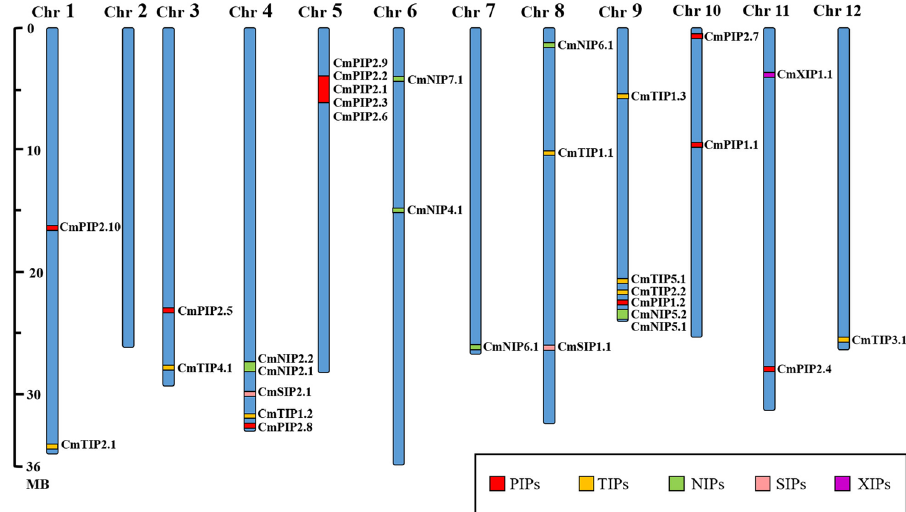
Figure 2. Chromosomal distribution of aquaporin genes in C. melo . The different MIP sub-families are distinguished using different-coloured boxes: PIPs (red), TIPs (yellow), NIPs (green), SIPs (pink) and XIPs (purple). The abbreviations are as follows: Cm ( C. melo ), Chr (chromosome). This figure was made with Microsoft Office 2016 package.